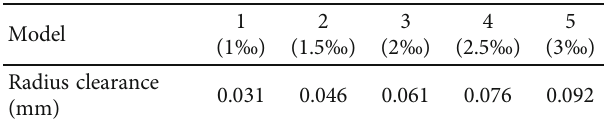
Table 10: Radius clearance of SFD